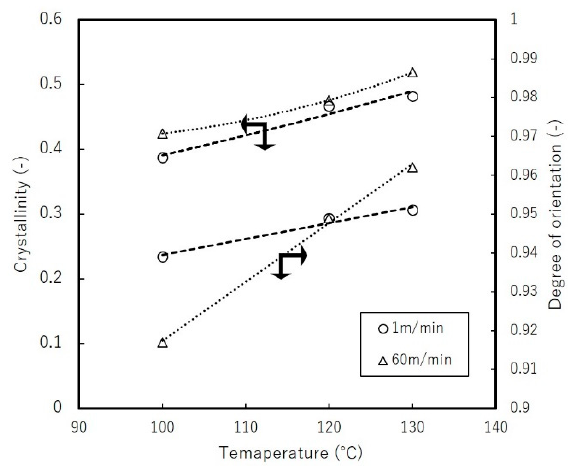
Figure 11. Crystallinity and orientation dependence on stretching temperature for uniaxial free-width stretched films by DR = 7.